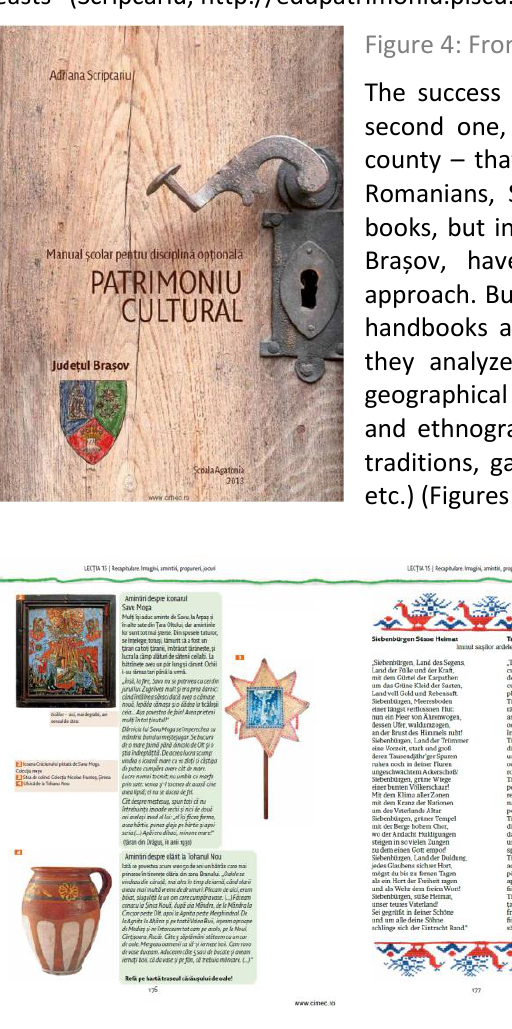
Figure 4: Front cover of Cultural Heritage (Scripcariu, 2012)